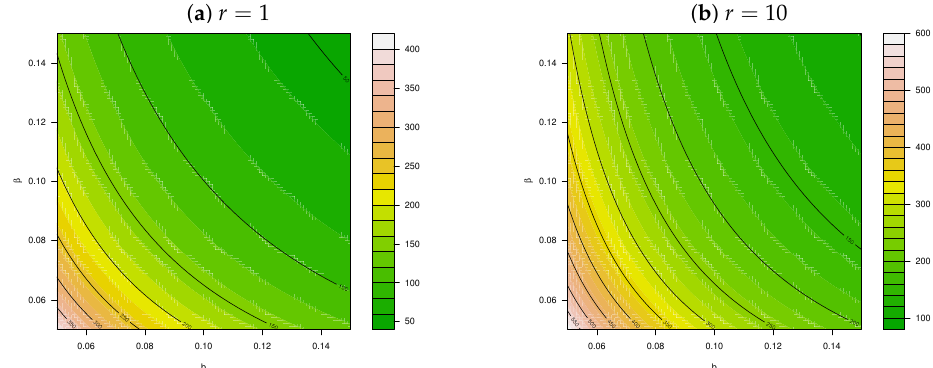
Figure 6. Dispersion index for X ∼ PncLII ( β , b , r ) for different values of ( β , b ) and r =